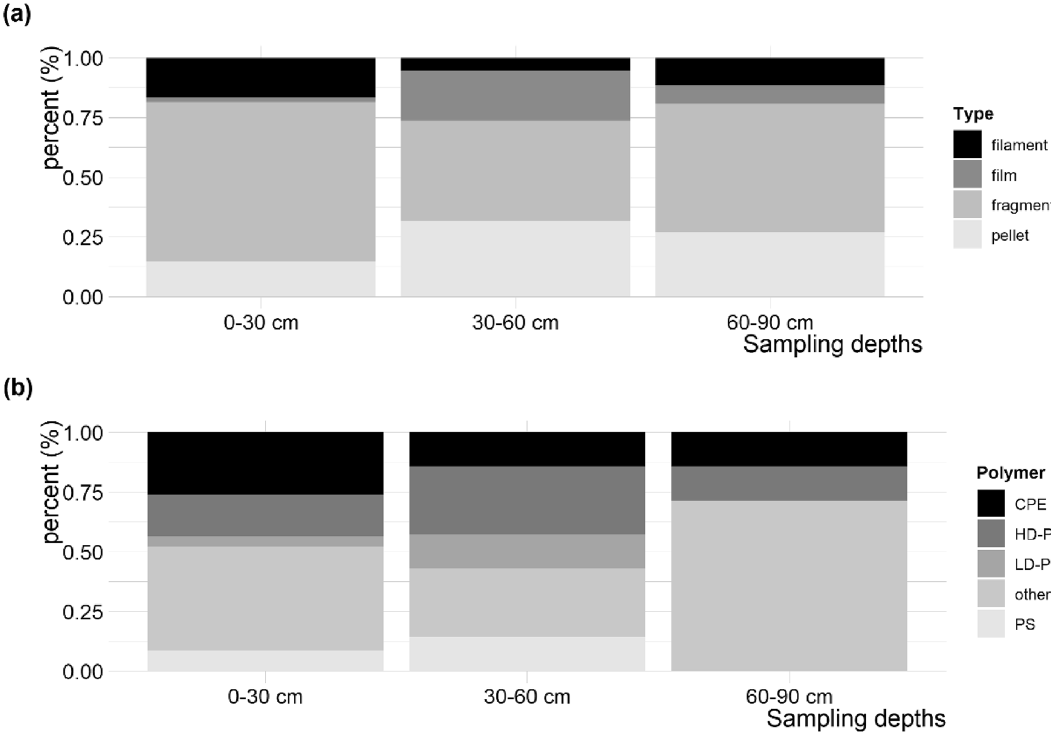
Figure 4. Characteristics of microplastic particles according sampling depths for ( a ) microplastic form types and ( b ) microplastic identity